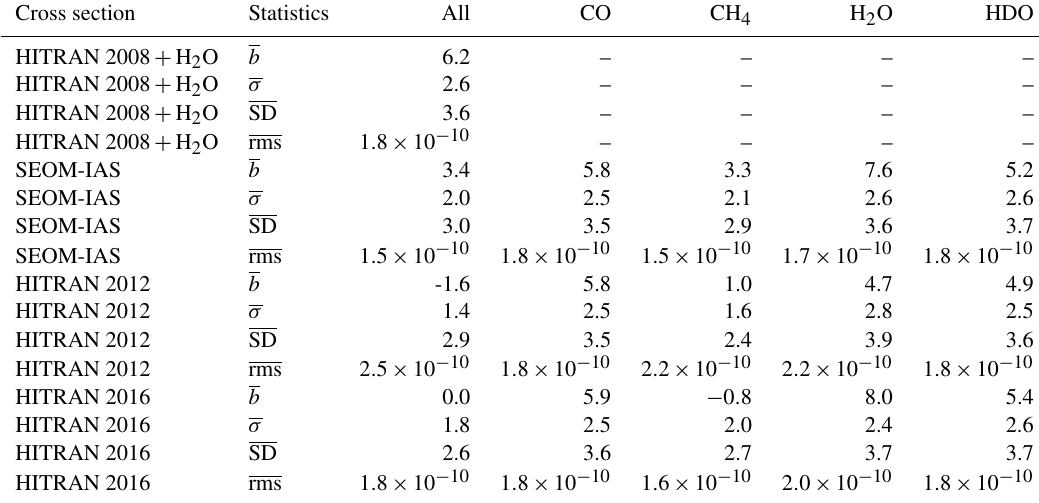
Table 1. TROPOMI CO bias with respect to TCCON ( b , σ , SD) and the spectral fit quality (rms) in mols − 1 m − 2 nm − 1 sr − 1 , as is introduced in Fig. 3, for different spectroscopic databases (HITRAN 2008 + H 2 O, SEOM-IAS, HITRAN 2012 and HITRAN 2016). The column “all” gives the values for when the spectroscopic databases are used for all species. The other columns indicate the characteristics for when the spectroscopy of only one species is updated. Here, only TROPOMI clear-sky retrievals are considered and no destriping is applied. Cross